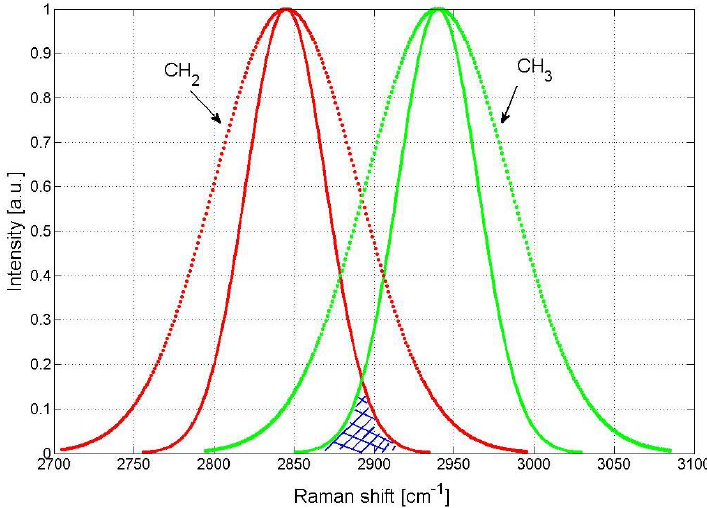
Figure 7. Raman bands for CH 2 (2845 cm − 1 , red circles) and CH 3 (2940 cm − 1 , green diamonds). Continuous lines are obtained considering the Ti:Sa and OPO cross-correlation reported in Figure 6 at the input of the microscope (i.e., 262 fs). Blue lines highlight the overlap area between two excited bandwidths.